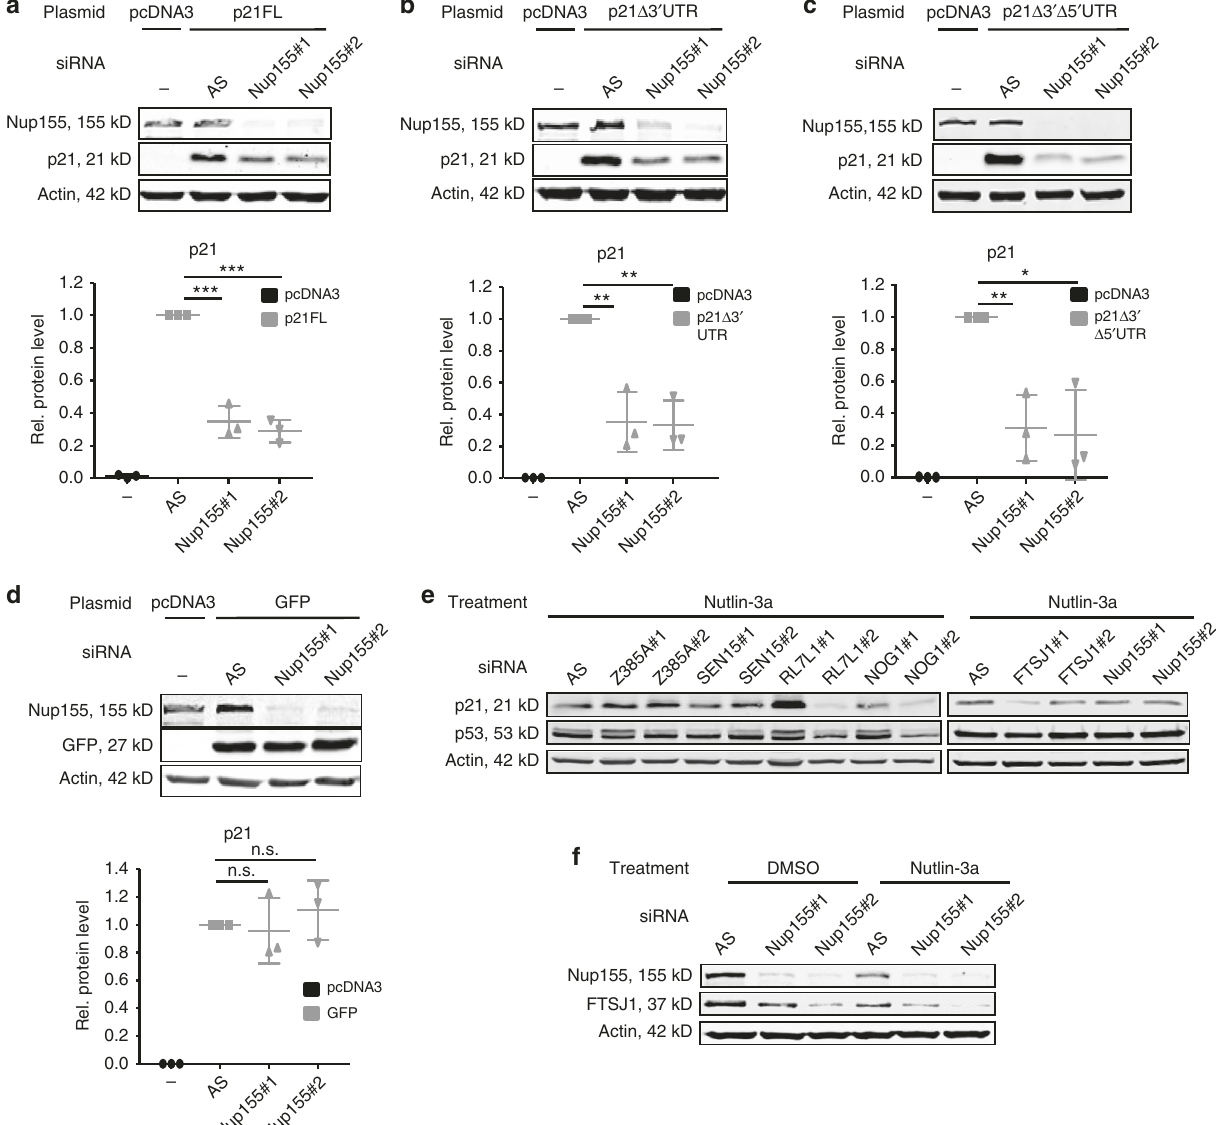
Fig. 3 Nup155-dependent p21 mRNA translation is independent of the 3 ′ /5 ′ UTR and potentially involves FTSJ1. a – d H1299 cells were treated either with control (AS) or two different Nup155 siRNAs (Nup155#1 and Nup155#2) for 72 h and either co-transfected with a control vector (pcDNA3) or different p21 expression constructs with p21 full-length (p21FL) ( a ) or constructs that lack either the 3 ′ UTR (p21 Δ 3 ′ UTR) ( b ) or the 5 ′ UTR and the 3 ′ UTR (p21 Δ 3 ′ Δ 5'UTR) ( c ). A GFP-expressing construct served as a negative control ( d ). Cell extracts were analysed by immunoblotting with the indicated antibodies (upper panels) and corresponding densitometric analyses derived from three independent experiments are shown in the lower panels and are normalised to the control siRNA condition. e Candidates with a suggested role in mRNA translation and downregulated upon Nup155 knockdown as revealed by the proteomic approach (see Fig. 1A) were included in a focused RNA i approach. Reduced p21 protein accumulation and unaltered p53 levels as assayed by immunoblotting were considered as phenocopy of Nup155 depletion. Corresponding immunoblots show p21 and p53 levels (under Nutlin-3a treatment) either from the control siRNA (AS) condition or the candidate knockdown conditions (using two different siRNAs #1 and #2). Actin served as loading control. f HepG2 cells were treated either with control siRNA (AS) or two Nup155 siRNAs (Nup155#1 and Nup155#2) for 72 h and p53 was induced by adding Nutlin-3a for 24 h. Cell extracts were analysed by immunoblotting with indicated antibodies. For densitometric analyses see Supplementary